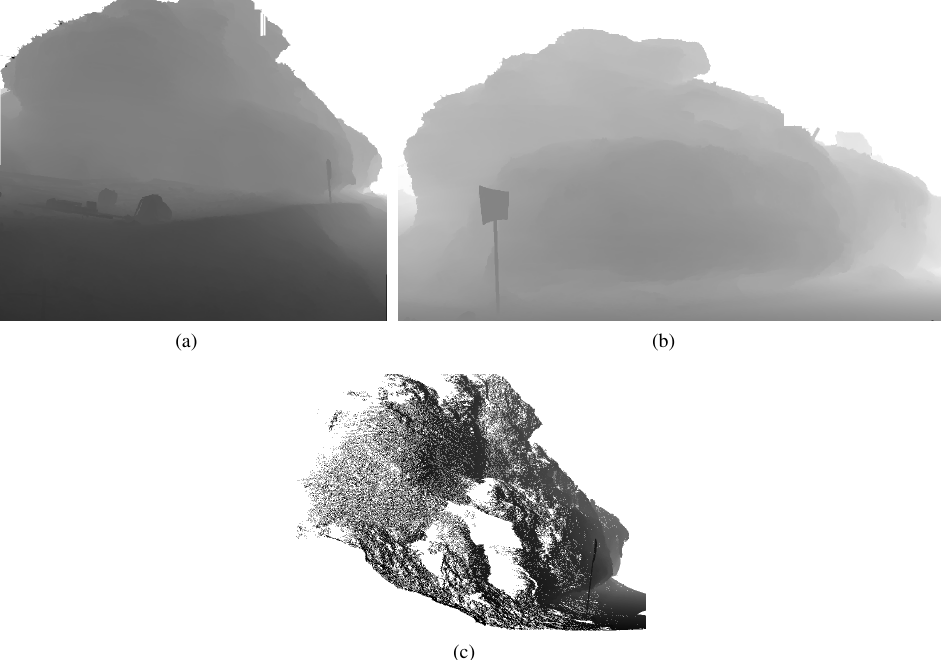
Figure 1: Scans in the panoramic representation, a) the reference scan, b) The analyzed scan in its original local reference frame (not transformed), c) The Analyzed scan in the panoramic representation and when transformed into the reference frame ∆ h provides a more subtle evaluation for point proximity in the detection of changes.